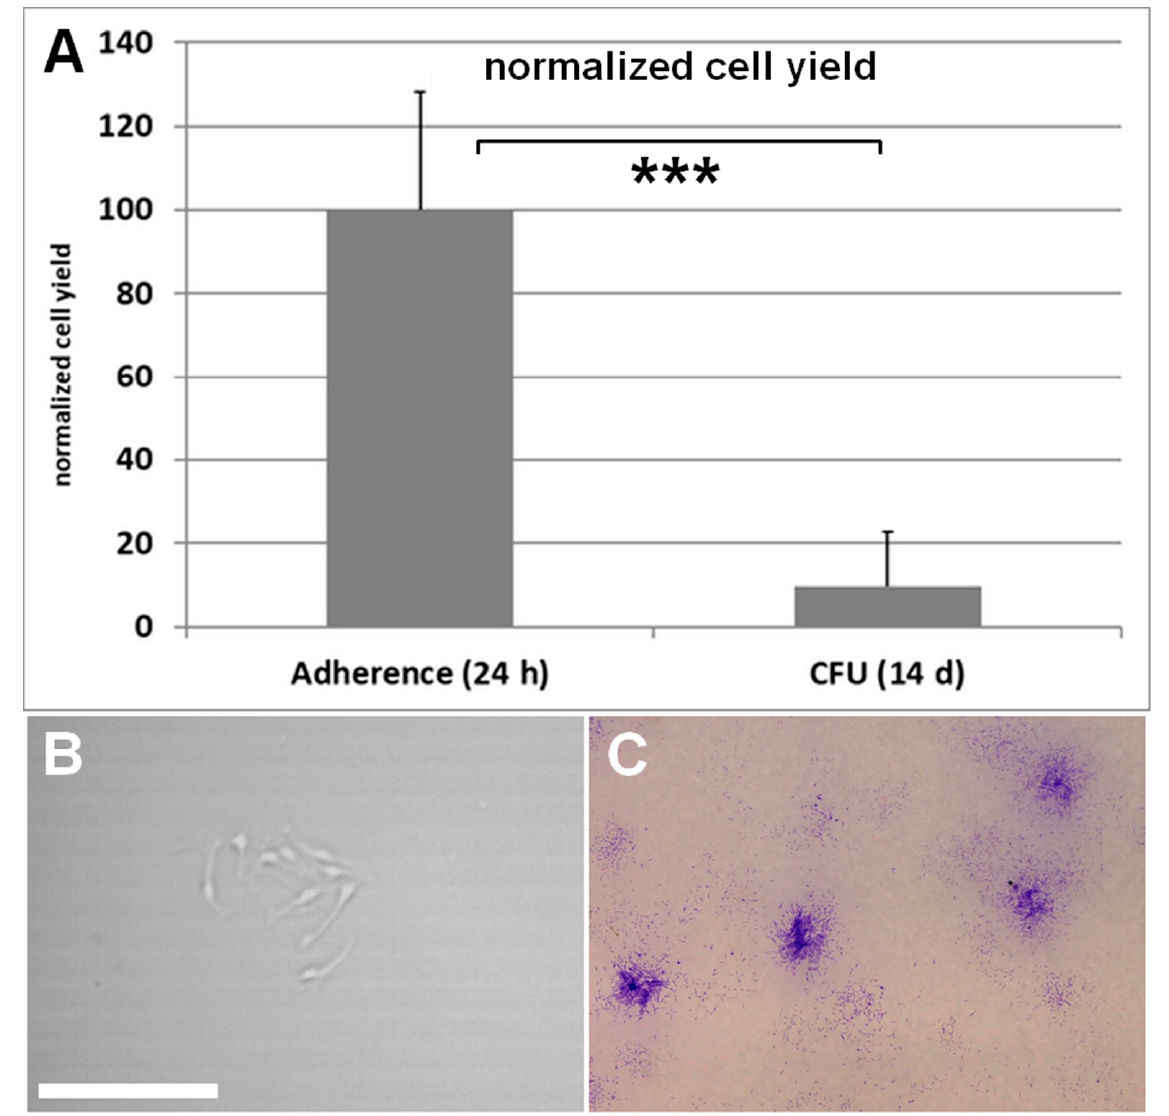
Figure 4. ( A ) Calculated cell yield is roughly 10 times higher when the adherent cell counting method is used compared to the colony forming unit assay. Results are shown as mean of five wells ± SD. Student’s test was used to assess statistical significance (***: p < 0.001). ( B ) A single colony after a few days of culture. The bar measures 100 µ m. ( C ) The stained (crystal violet) colonies can be seen macroscopically after two weeks.